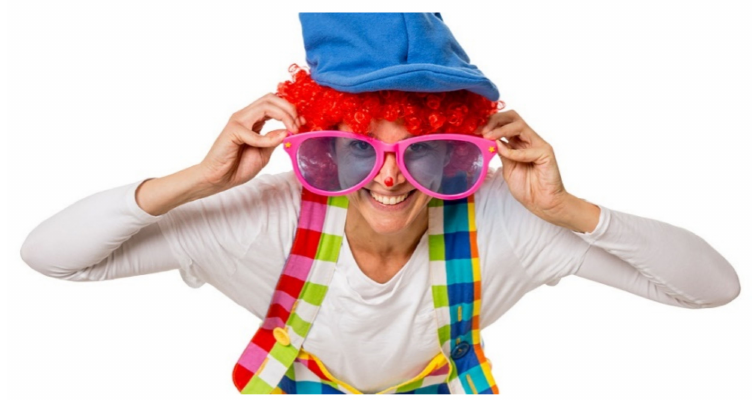
Figure 1. Clown Zitzewitz, the ‘Sun protection clown’ © NCT/UCC 2020.